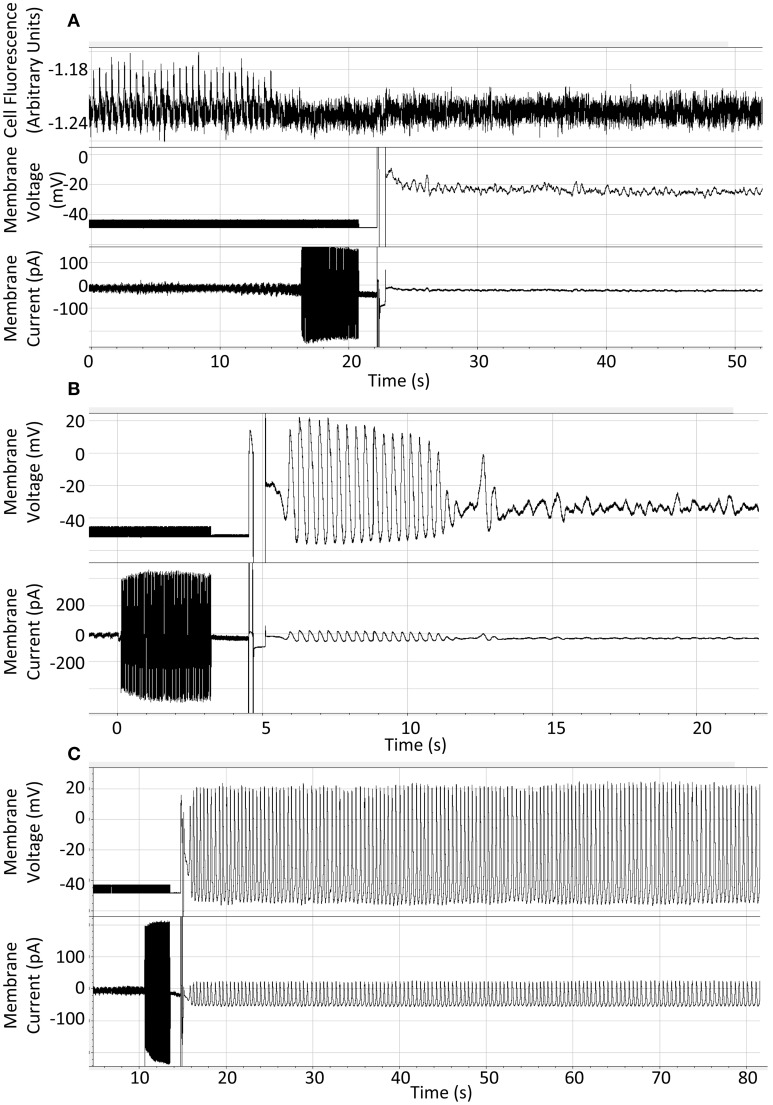
(A) Representative recording to show result of patch-application of 10 mM BAPTA to an isolated guinea pig SAN cell with fluo5F included to demonstrate rhythmic activity under control conditions. (B) Representative recording to show rapid cessation of spontaneous activity on application of 10 mM BAPTA from the patch pipette solution. (C) Representative recording to show continuation of expected spontaneous rhythmic action potential generation when whole-cell access is gained using standard whole-cell patch solution. Cells were superfused with Physiological Saline Solution at 35 ± 2°C throughout.